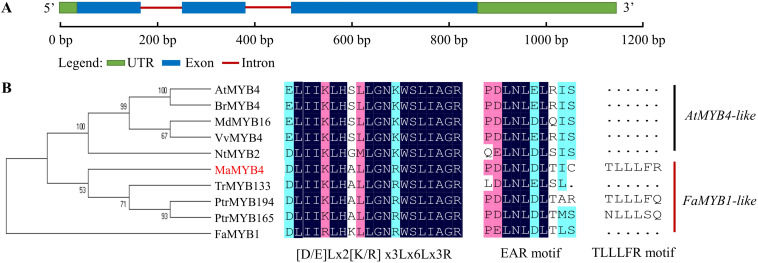
Sequence analysis of MaMYB4 and other nine R2R3-MYB repressor transcription factors (TFs). (A) Schematic representation of the sequence organization of MaMYB4. (B) Phylogenetic analysis and amino acid sequence alignment of MaMYB4 and other nine R2R3-MYB repressors from various organisms. The amino acid sequences were aligned using the Clustal Omega, and the tree was drawn with neighbor joining method using MEGA software 5.0. They have the conserved motif of [D/E]Lx2[R/K]x3Lx6Lx3R and EAR. In addition, MaMYB4 contains TLLLFR motif, and it belongs to FaMYB1-like R2R3-MYB repressor (Chen et al., 2019b).